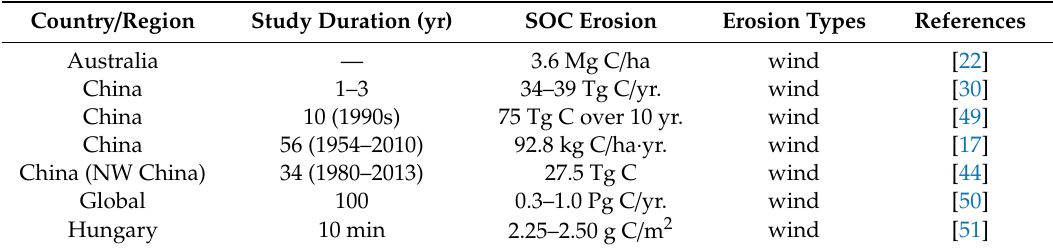
Table 3. Examples of regional, national, or global terrestrial SOC erosion by wind. Country / Region